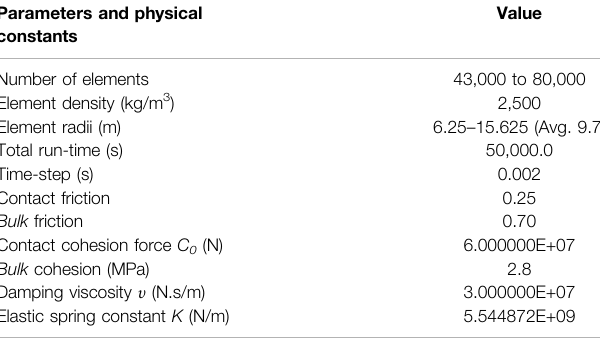
TABLE 1 | Model parameters. Parameters and physical